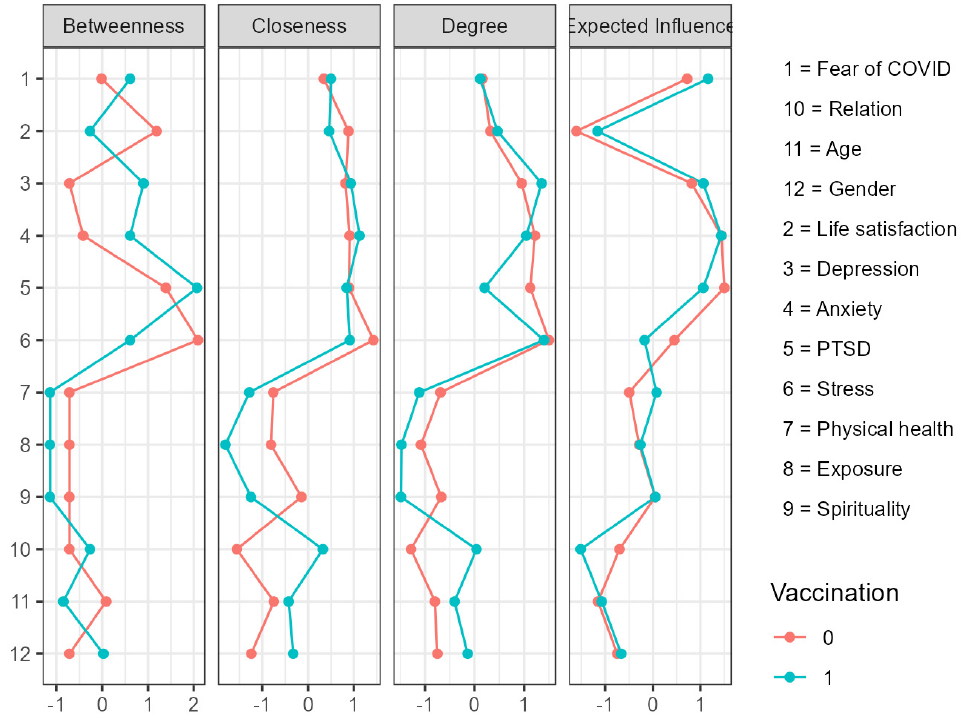
Figure 3. Centrality plot (betweenness, closeness, degree, and expected influence). Standardized Z score values in several demographic variables and well-being dimensions among vaccinated = 0 (red) and unvaccinated = 1 (green) samples of university students during the fourth wave of the COVID-19 pandemic. N = 706.